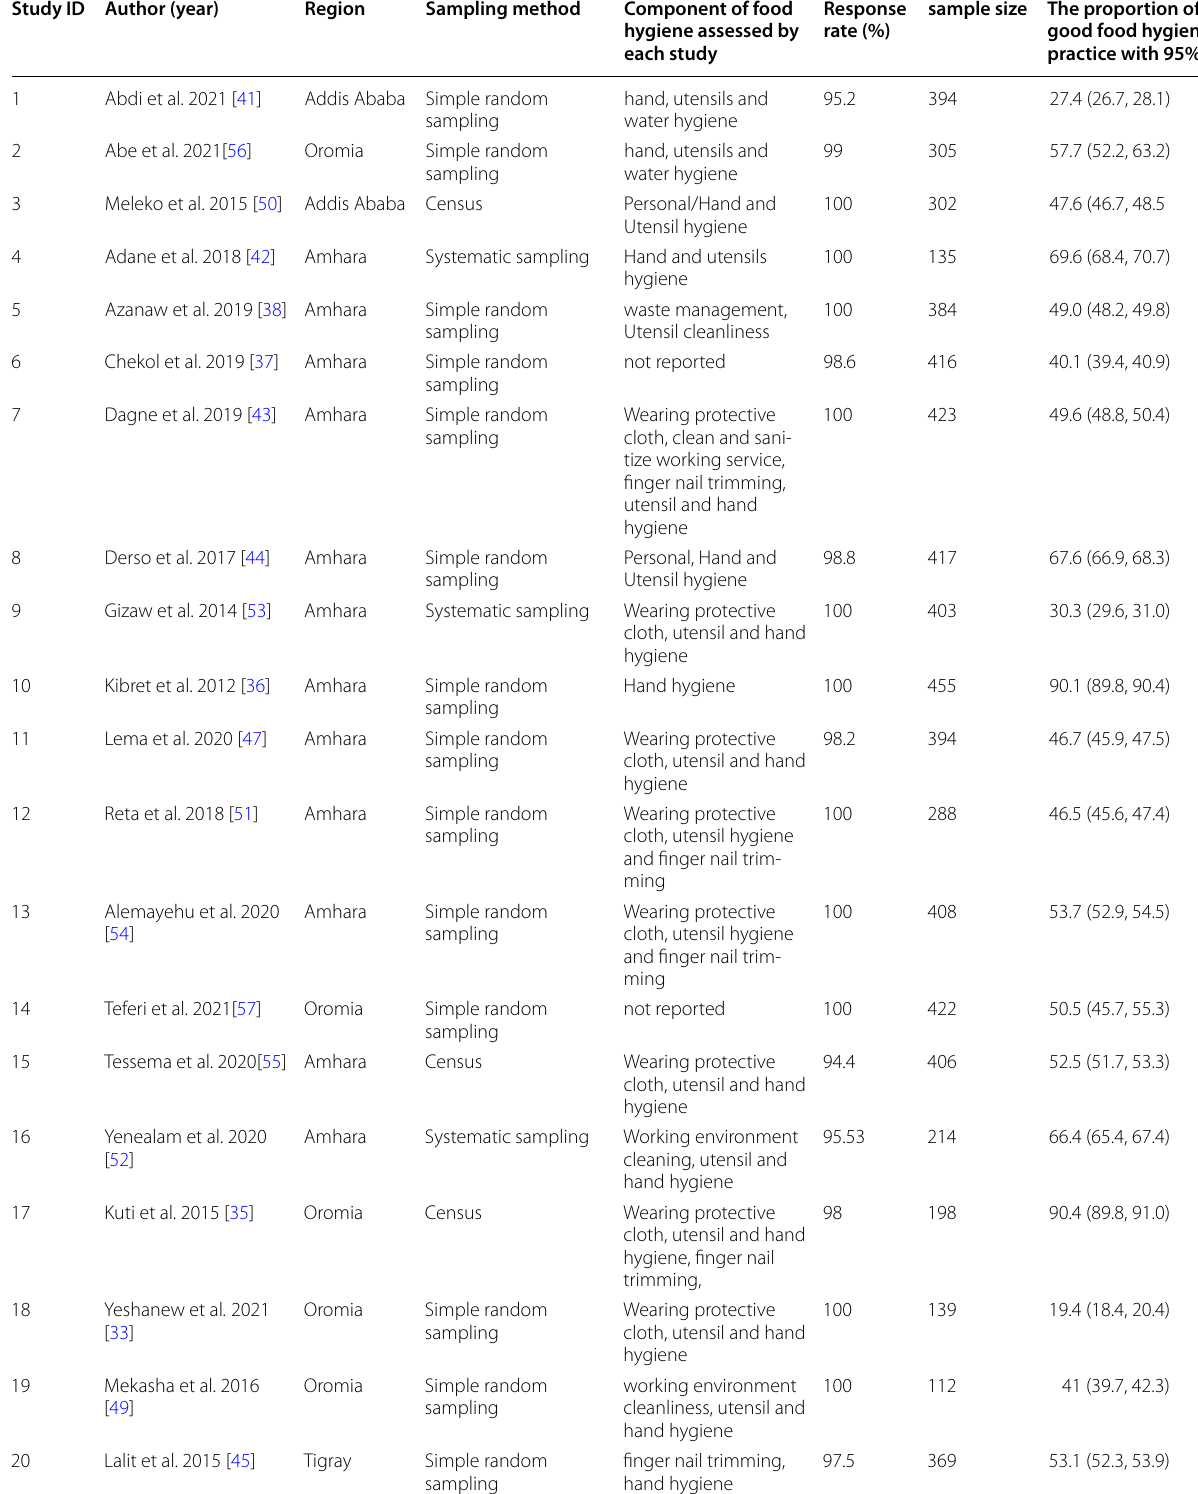
Table 1 Descriptive summary of 23 studies included in the meta-analysis to estimate good food hygiene practice among food handlers in